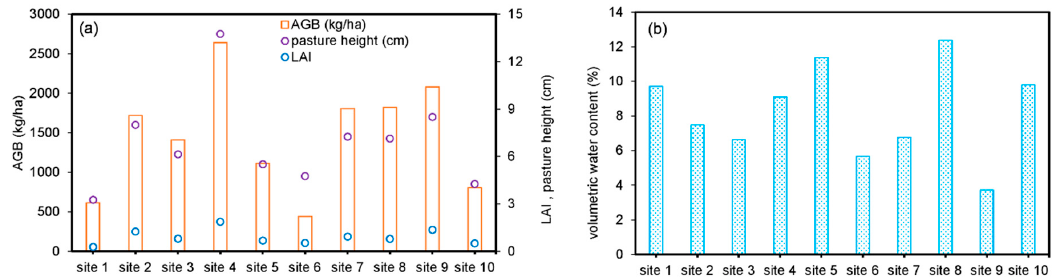
Figure 4. The field measured; ( a ) leaf area index (LAI), pasture height and aboveground biomass (AGB) and ( b ) volumetric water content for each site.